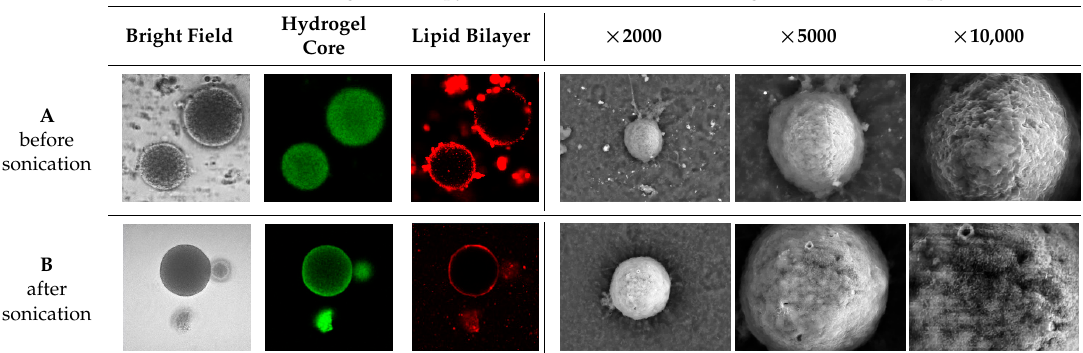
Figure 8. Confocal and electron microscopy images of the lipobeads resulted from mixing PNIPA-FA hydrogel microspheres and lipidic formulation #1 in Table 1 before ( A ) and after ( B ) sonication, respectively. The Green images originate from fluorescein- o -acrylate (FA) covalently attached to the PNIPA network. The Red images originate from rhodamine B covalently attached to the heads of phospholipid (RhodB-PE). For the CLSM images, an aliquot of the lipobeads’ suspension was placed onto the depression slide. For the SEM images, the wet lipobeads from the same batch were deposited on a carbon tab adhered on the SEM mount.